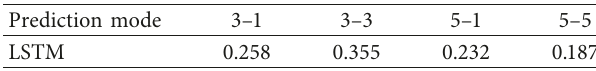
Table 6: Average error of prediction results under different conditions.